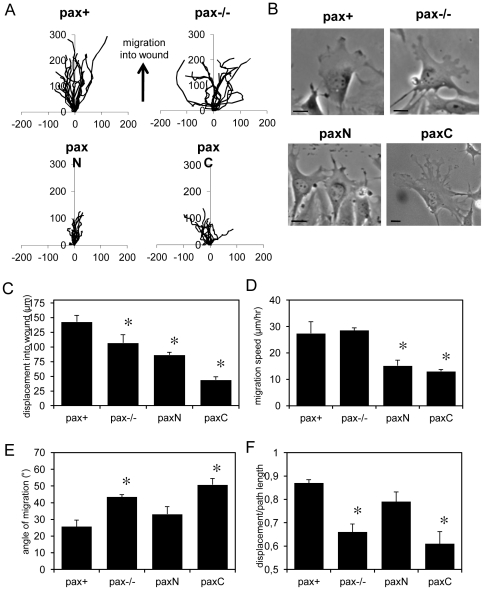
Paxillin deficiency leads to loss of directional persistence, but not migration speed; paxN rescues directional migration into scrape wounds, but expression of either half of paxillin alone results in decreased cell speed.A) Paths of individual cells at the edge of scrape-wounds over 6 h. B) Representative images of cells at the wound edge. Note thin, spiky protrusions in the paxN cell and multiple lamellipodia in pax−/− and paxC cells. Scale bar = 10 µm. C) Displacement into the scrape wound after 6 h. D) Migration speed of cells migrating into scrape wounds. E) Average angle of migration into scrape wounds (90° = perpendicular to wound edge). F) Displacement/path length ratio (1 = perfectly straight path into wound). * p<0.001 compared to pax+.